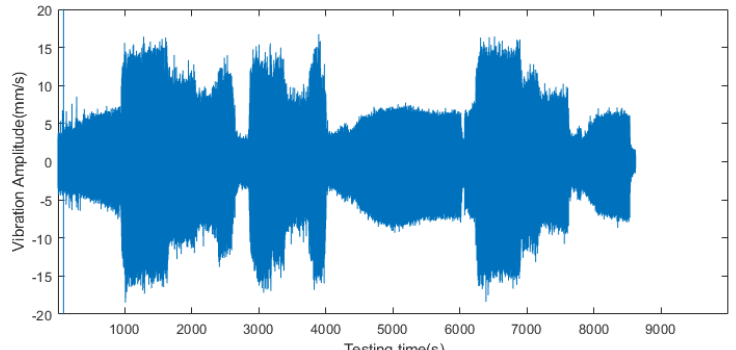
Figure 6. Gas turbine vibration signals at front measuring point.